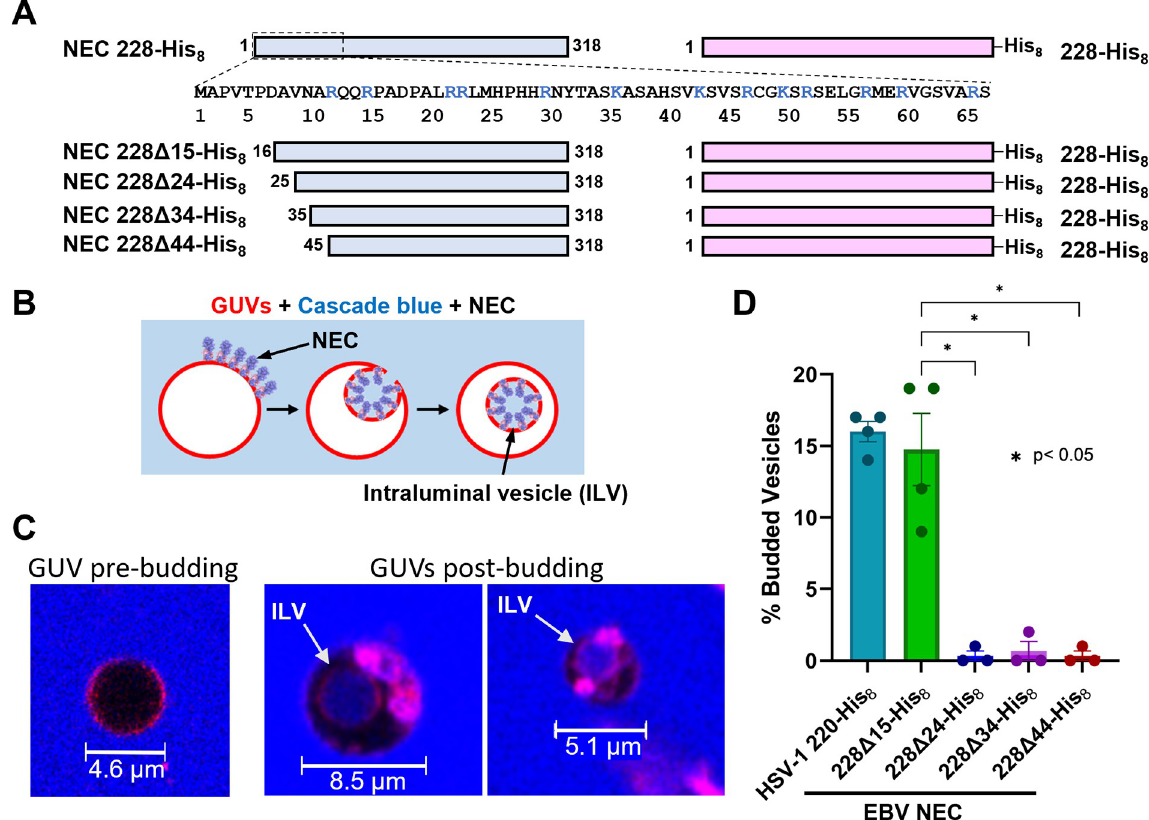
Fig 6. EBV NEC buds synthetic membranes. (A) EBV NEC constructs used. Sequence of EBV BFLF2 1–67 are shown. (B) A diagram of the in-vitro budding assay. GUVs (red) bind NEC (purple and pink) which generates formation of membrane curvature allowing cascade blue (light blue) to enter the forming ILV. (C) Images of pre and post NEC-budded vesicles from confocal experiments. ILVs are shown with arrows. (D) In-vitro budding assay. Vesicles contain Ni-chelating lipids to tether His 8 -tagged NEC to membranes. % budding was determined by counting the number of intraluminal vesicles (ILVs) after addition of NEC. Background levels of ILVs in the absence of NEC, typically around 10%, were subtracted from all values. Significance to 228 Δ 15-His 8 was calculated using an unpaired Student’s t-test with Welch’s correction (p < 0.05 = � ). In all plots, error bars represent the standard error of the mean (68% confidence interval of the mean) for at least three individual